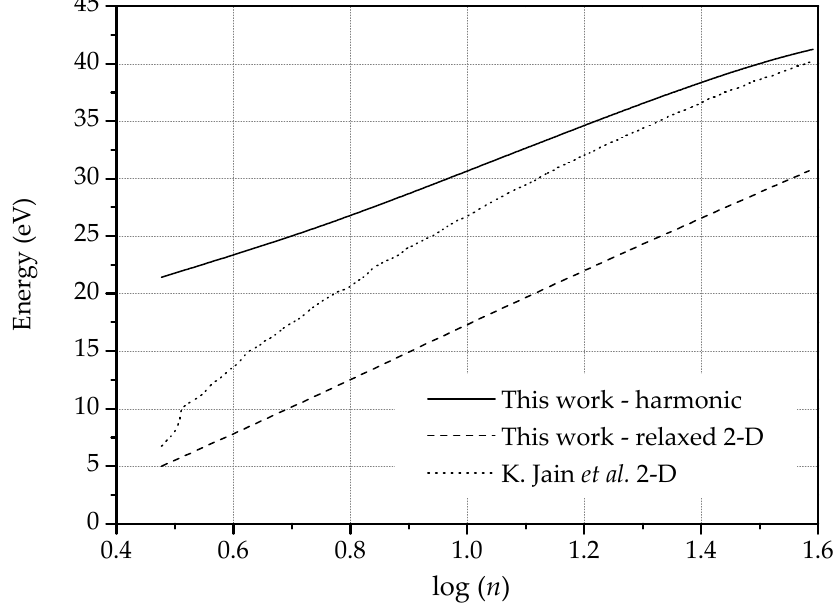
Figure 6. Dislocation energy as a function of dipole size, n , in 2-D with the force constants model, after relaxing harmonic configurations and presented by S.K. Jain et al.